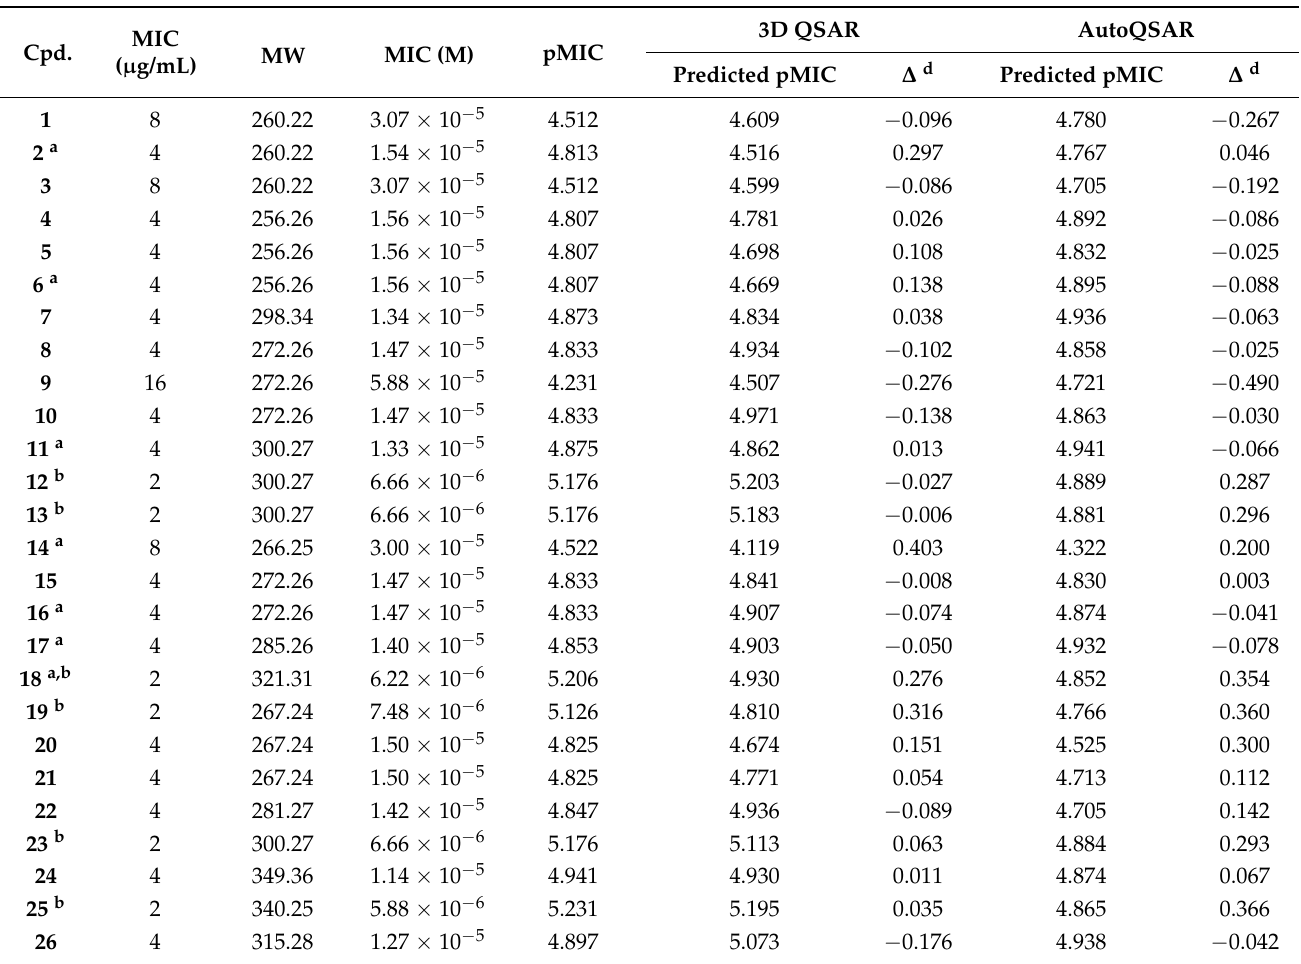
Table 1. Compounds selected for modeling and their measured and predicted antimicrobial activity against S. aureus